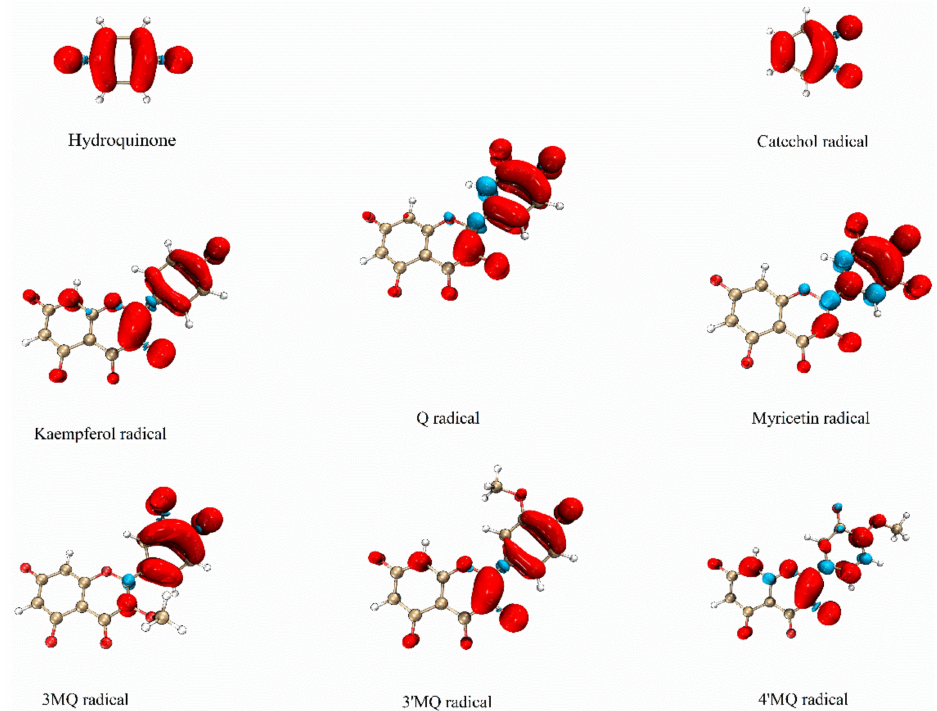
Figure 5. The spin density map of the deprotonated radicals in water. The red color represents the alpha electron and the blue color represents the beta